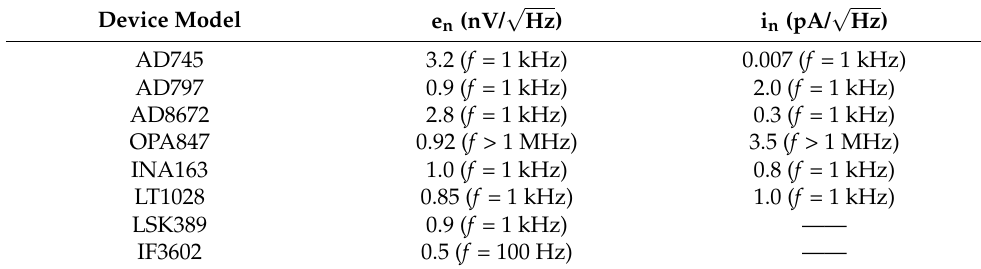
Table 1. Comparison of noise performance of low-noise